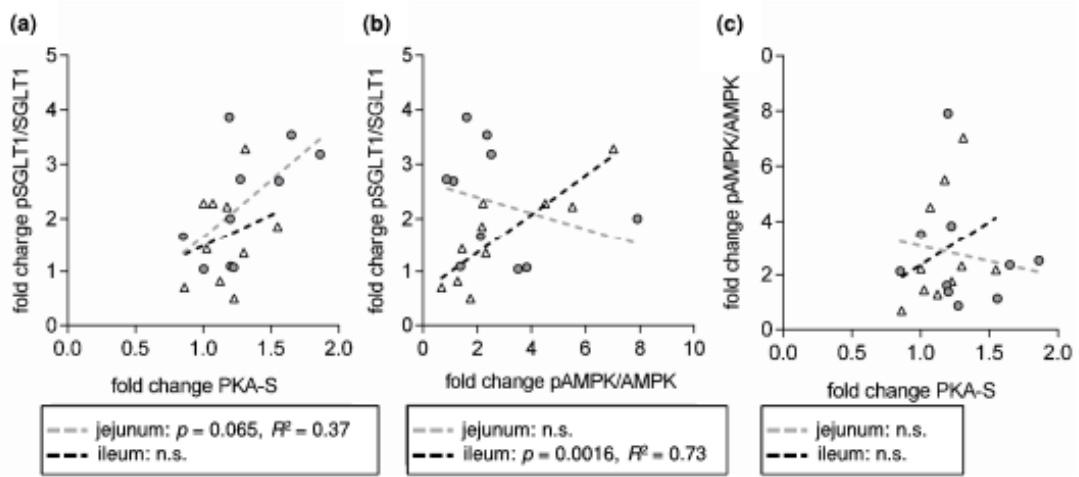
Figure 7. Correlation analysis of the relative changes in protein phosphorylation levels expressed as fold change of resveratrol-treated samples compared to control samples. ( a ) fold change in pSGLT1/SGLT1 vs. fold change in the amount of phosphorylated PKA substrates (PKA-S) ( b ) fold change in pSGLT1/SGLT1 vs. fold change in pAMPK/AMPK ( c ) fold change in PKA-S vs fold change in pAMPK/AMPK. n = 10.